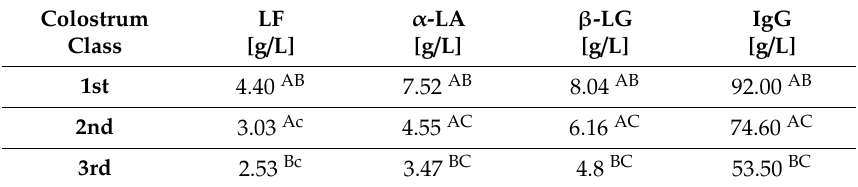
Table 3. The level of LF, α -LA, β -LG and IgG depending on the class of cows’ colostrum.